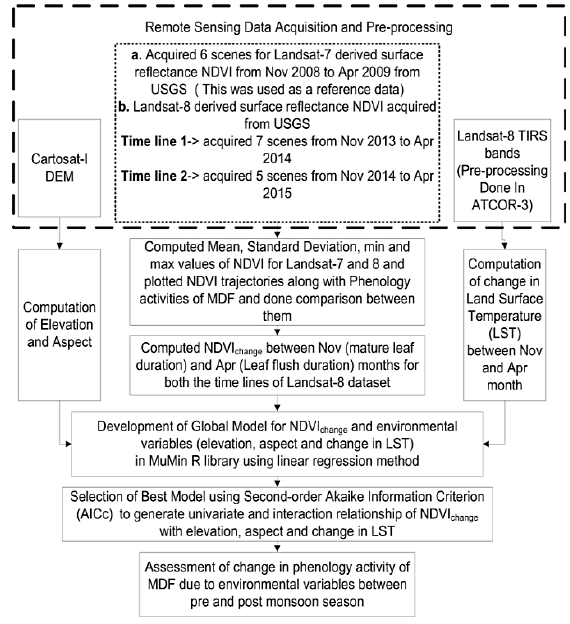
Figure 2: Flow chart of